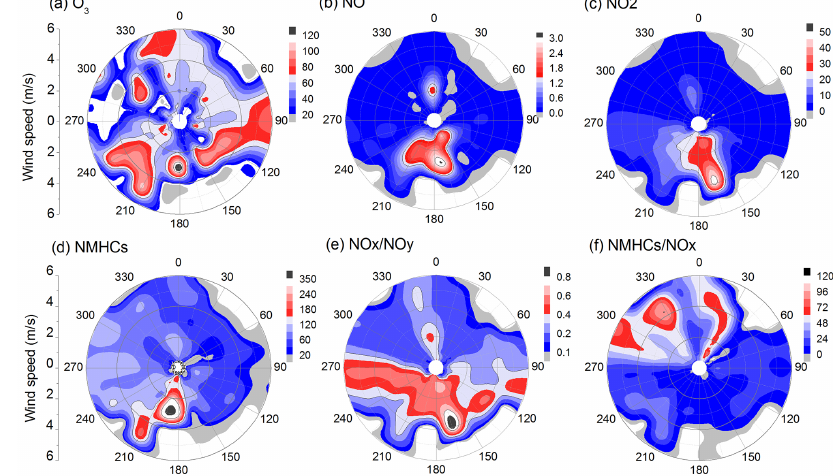
Figure 4. Dependence of the mixing ratios of (a) O 3 , (b) NO, ( C ) NO 2 , (d) NMHCs, (e) NO x / NO y , and (f) NMHCs / NO x on wind direction and speed.